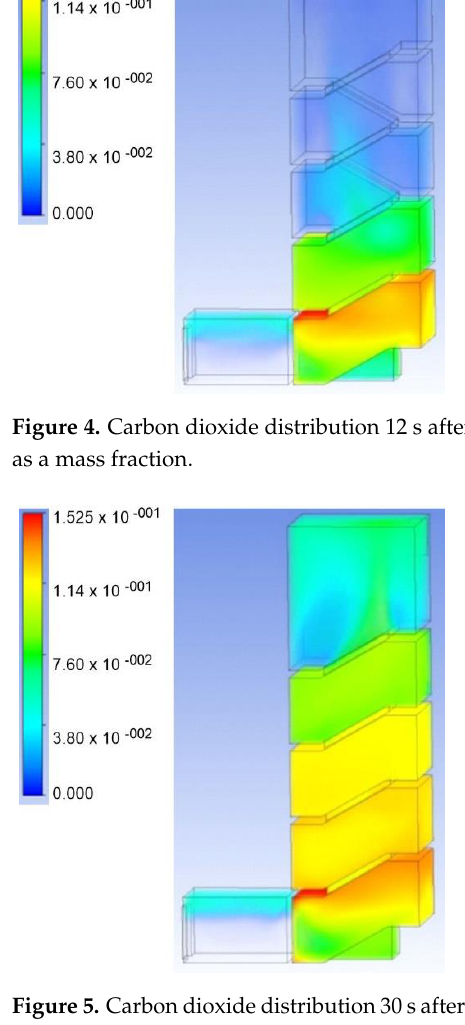
Figure 5. Carbon dioxide distribution 30 s after the door was opened. Carbon dioxide was a meas- ured as mass fraction. as mass